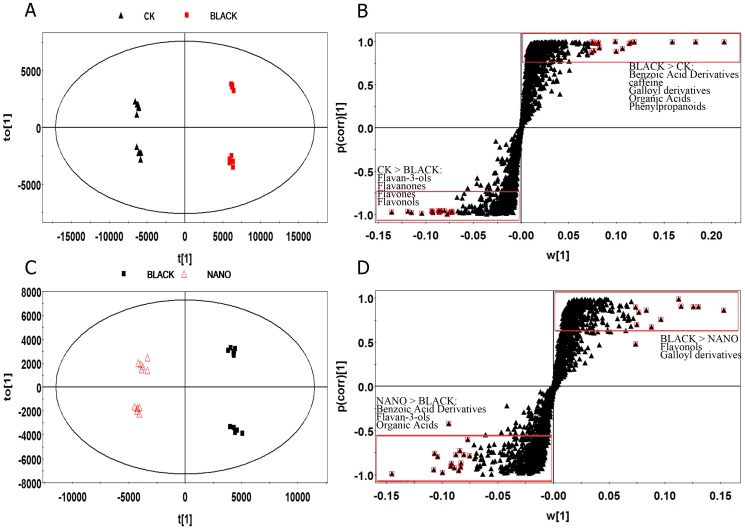
OPLS-DA score plots (A and C) and loading S-plots (B and D) of metabolites analyzed by UPLC-Q-TOF MS in young tea shoots shaded with Black Net (Black), Nano-insulating Film (Nano) or un-shaded (CK).A, B: Black Net VS un-shaded control, C, D: Nano-insulating Film VS Black Net. Red plots (the triangles in red squares) represent the 2% of compounds with the most positive or negative VIP values and P<0.001 (VIP is Variable Importance in the Projection).